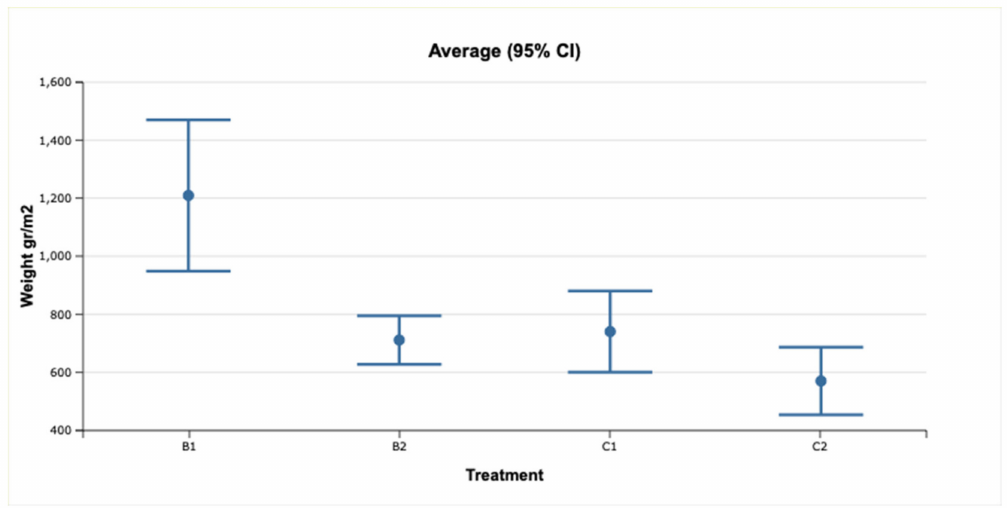
Figure 2. Dry grain weight per square meter in different treatments ( n = 10). Mean ± standard deviation. Control: plots without biochar; B1: plots supplemented with biochar B1; B2: plots supplemented with biochar